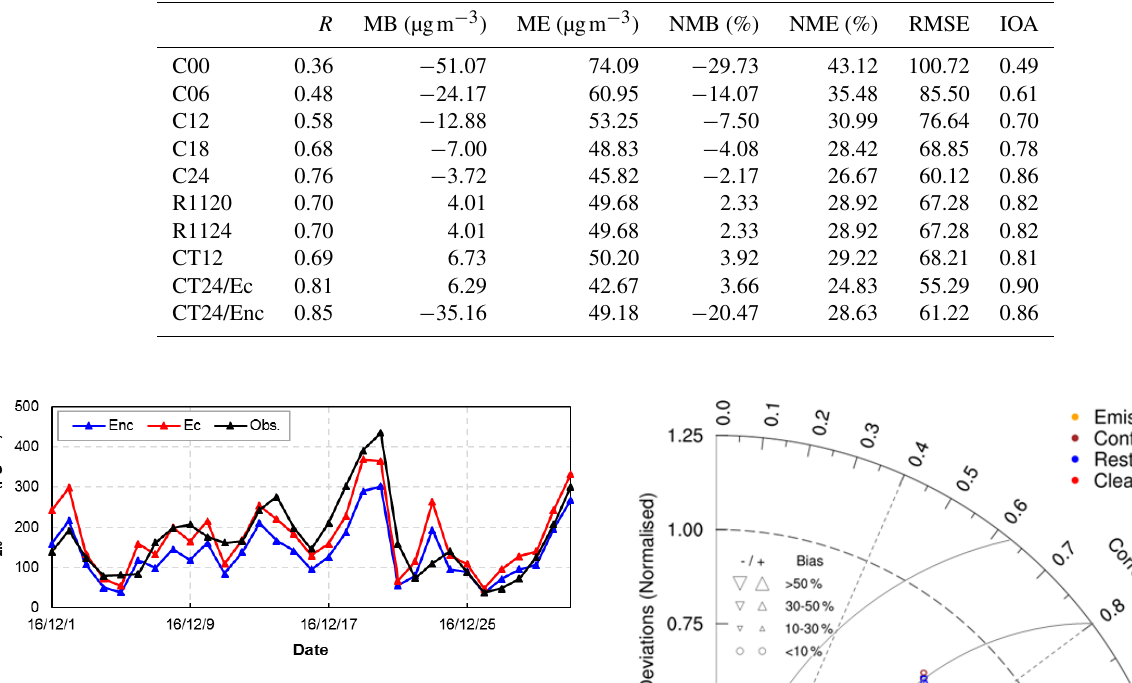
Figure 12. Time series of daily observed and simulated PM 2 . 5 con- centrations averaged from 13 NSAQ observation stations during December 2016 in Xi’an. The black line represents the observa- tions, the blue line represents simulated values from the CAMx model including construction fugitive dust, and the red line repre- sents the simulated values without construction fugitive dust.